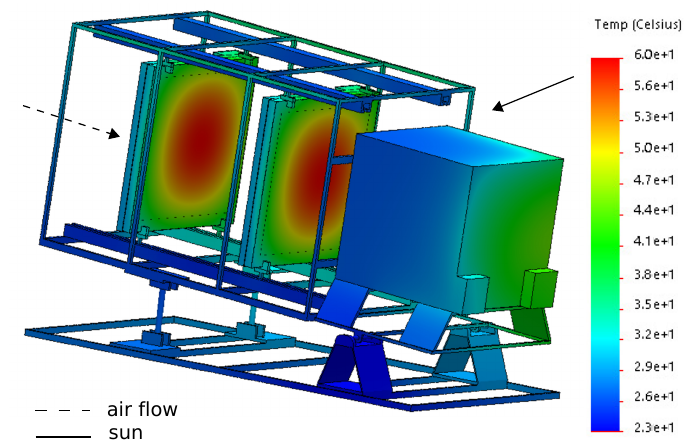
Figure 11. Heat distribution of the MuTe structure under the environmental conditions at the Cerro Machín volcano. The solid arrow represents the incident solar radiation while the dashed arrow indicates the wind direction. The maximum temperature at the centre of the scintillation panels reaches 60 ◦ C.